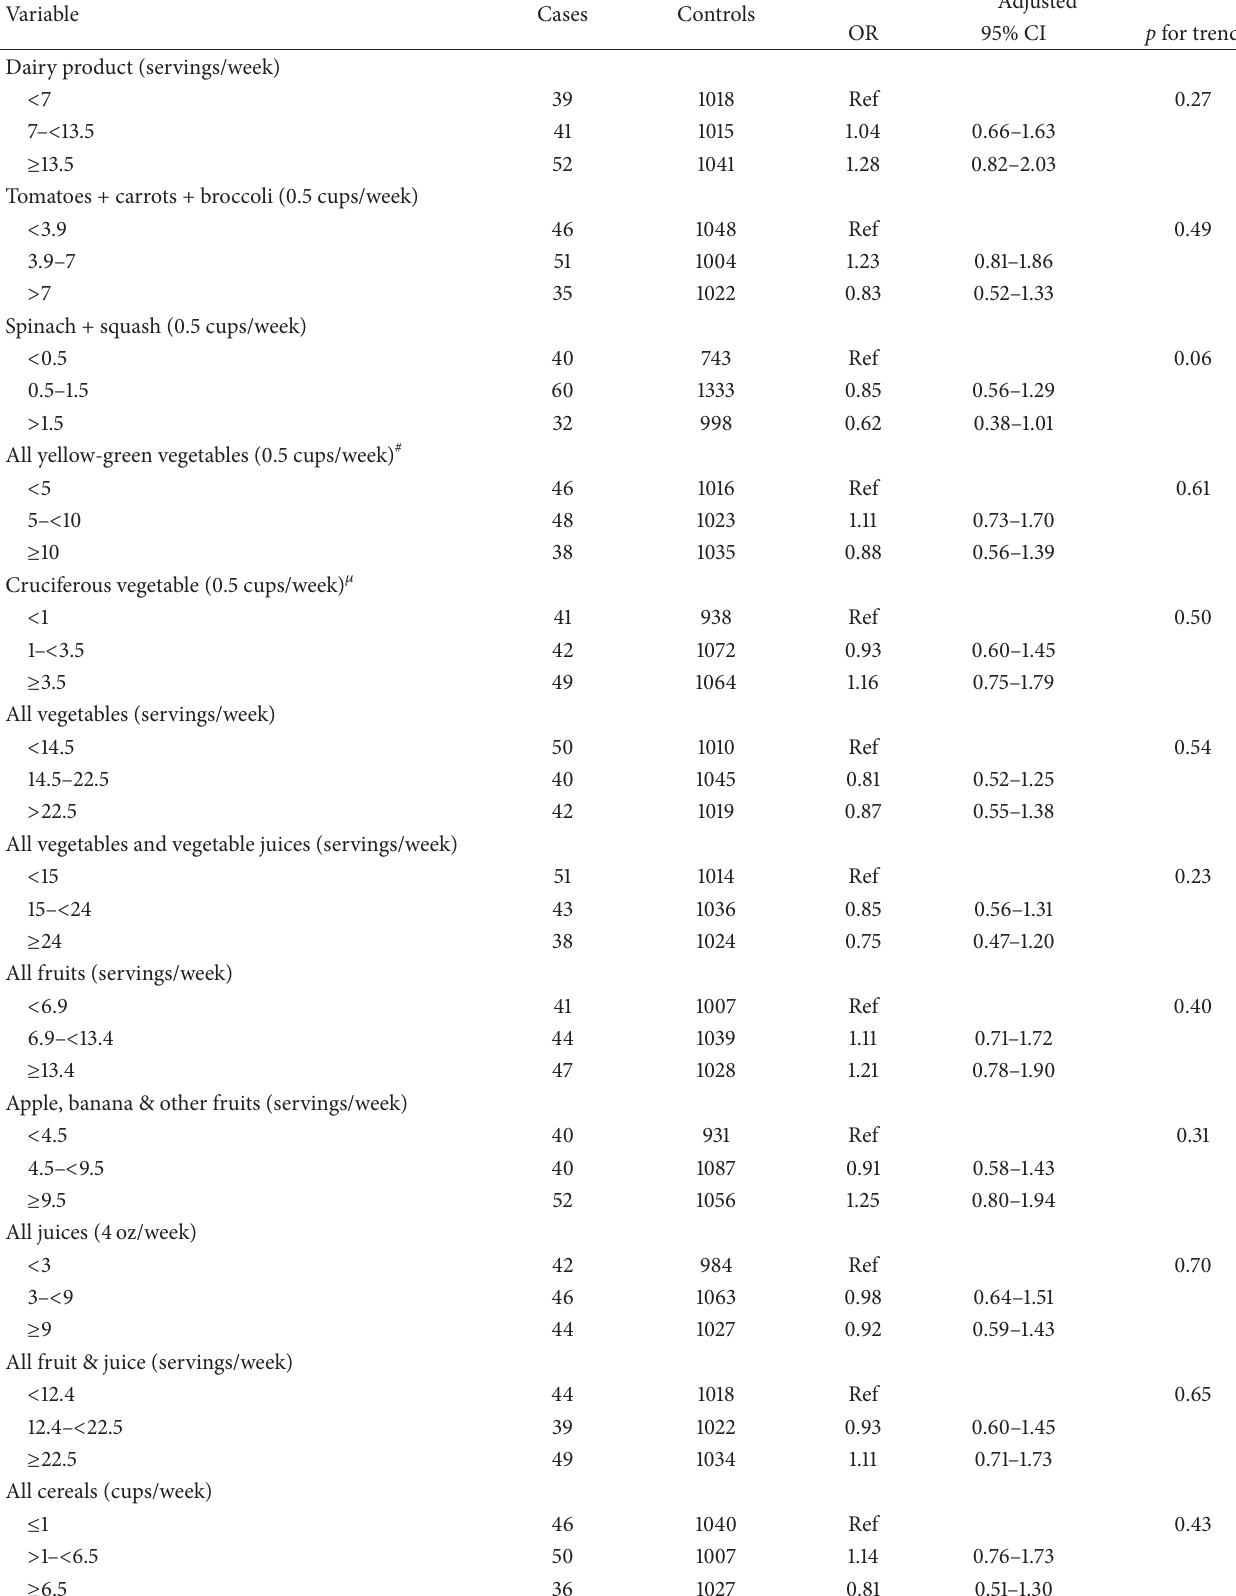
Table 3: Odds ratios of salivary gland cancer associated with some food